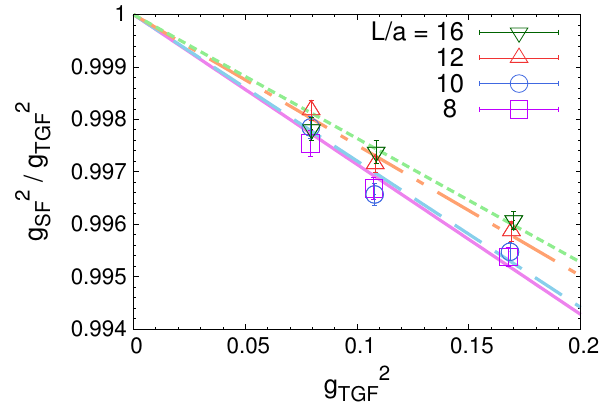
Figure 7 . The ratio between the SF coupling and TGF coupling vs the TGF coupling. The lines show the (cid:12)t results with linear